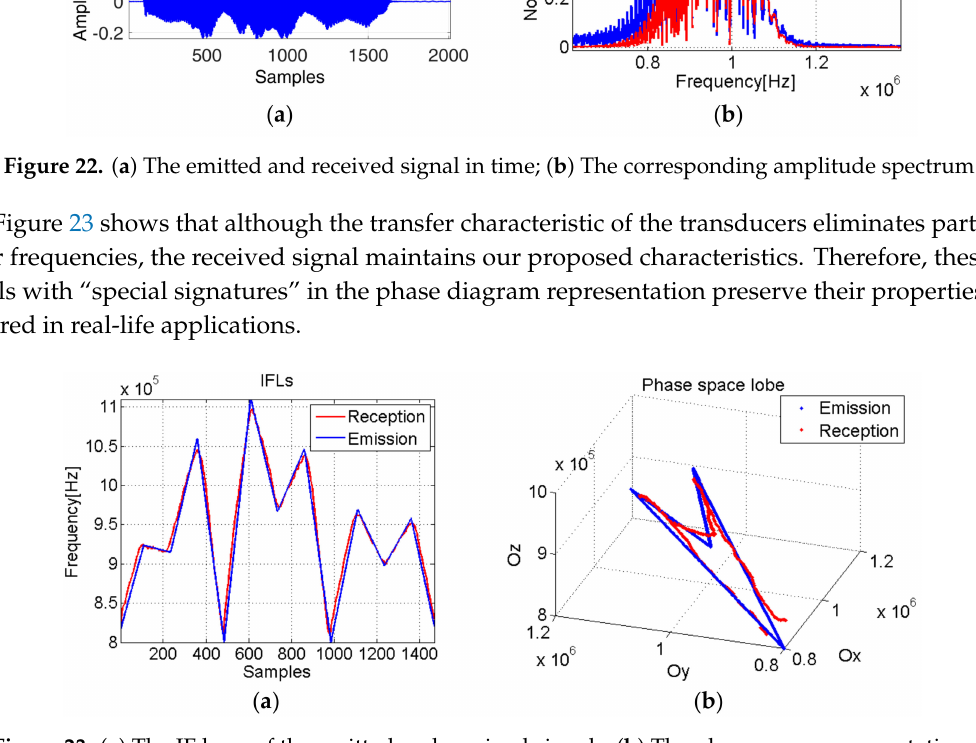
Figure 23. ( a ) The IF laws of the emitted and received signals; ( b ) The phase space representation of the IF